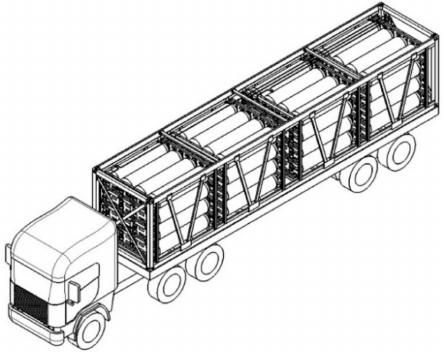
Figure 1. Hydrogen transport truck with tube skid